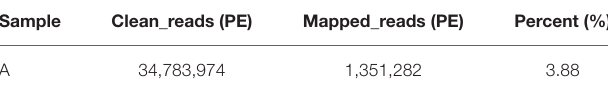
TABLE 8 | Comparison results of clean reads and virus